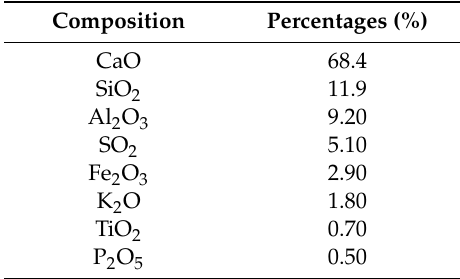
Table 1. Components of the HESC material.